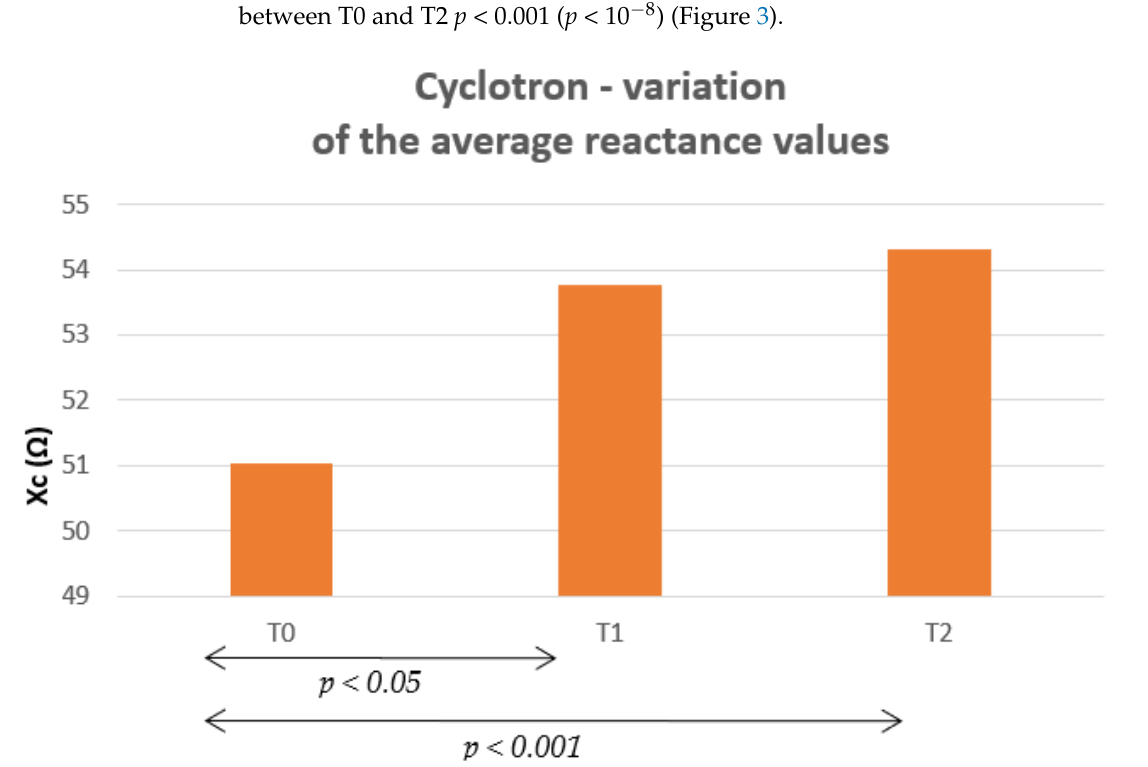
Figure 3. After exposure to ion-cyclotron emission, average reactance statistically significantly increases at T1 and further at T2, in selected acupuncture points.